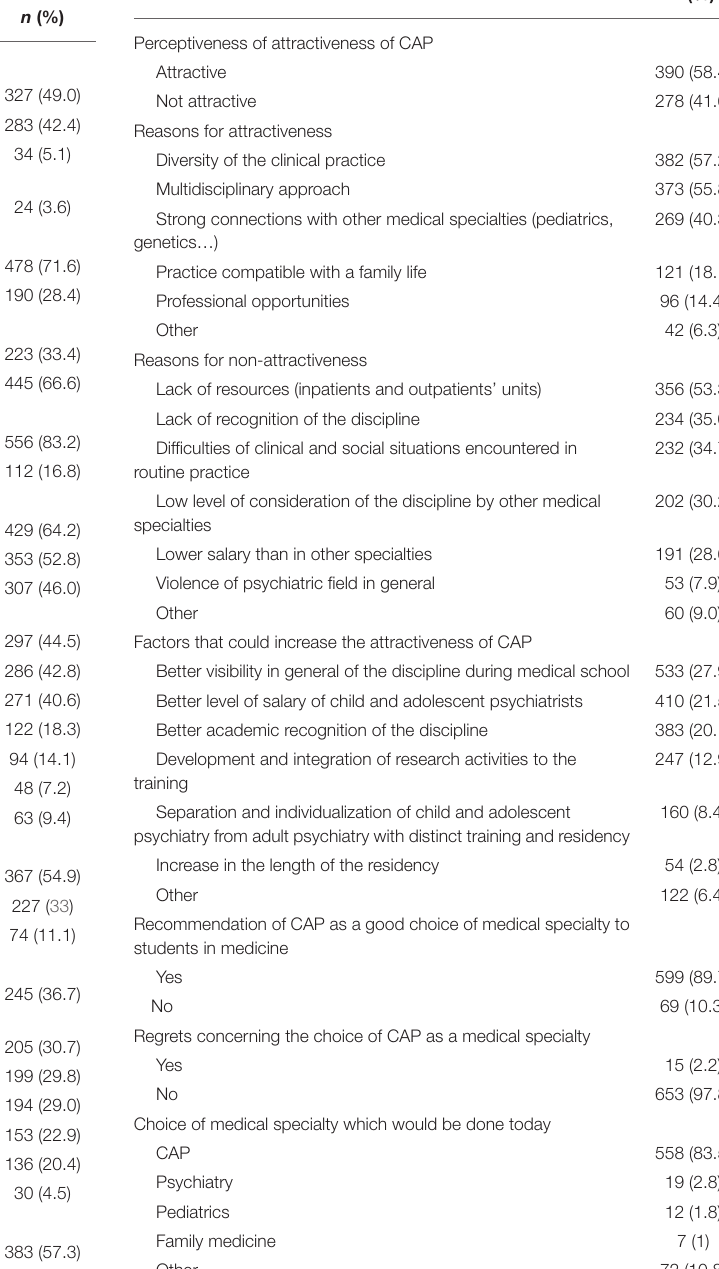
TABLE 3 | Factors associated with the choice of child and adolescent psychiatry ( n =